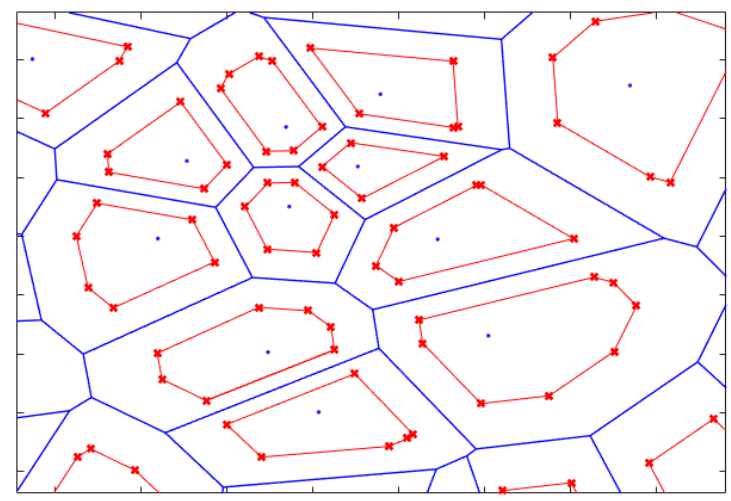
Figure 4. Small Cells with irregular shape center zone similar to cell boundary.